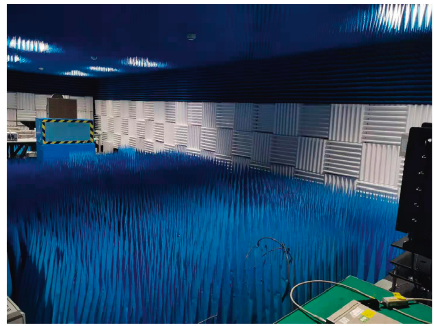
Figure 14: The far-field setup of the experiment.